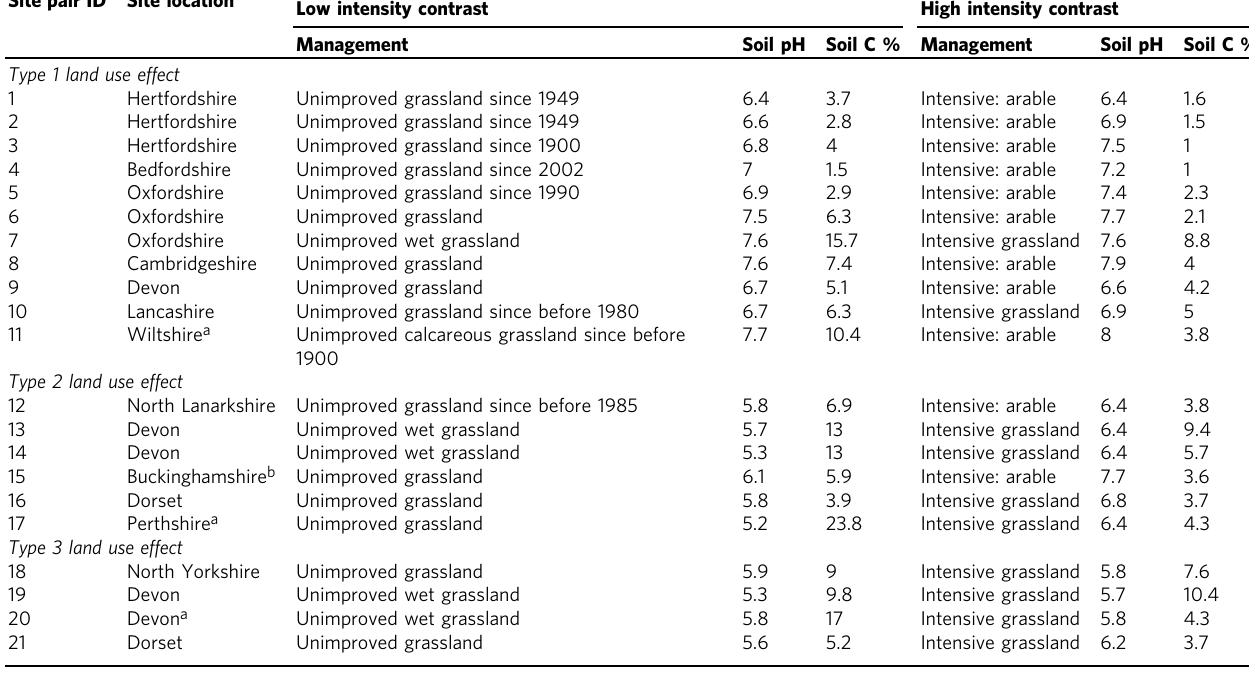
Table 1 Characteristics of land use contrasts Site pair ID Site